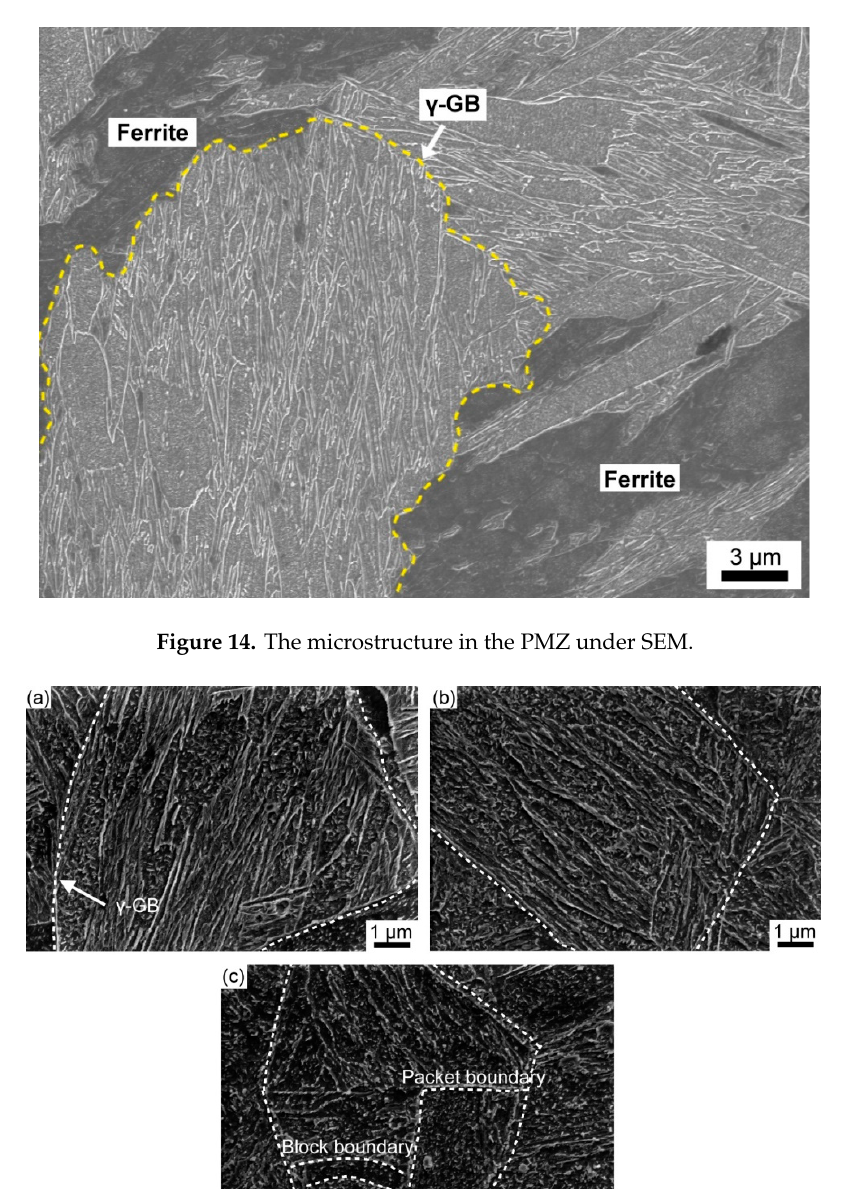
Figure 13. An overview of the PMZ under SEM.